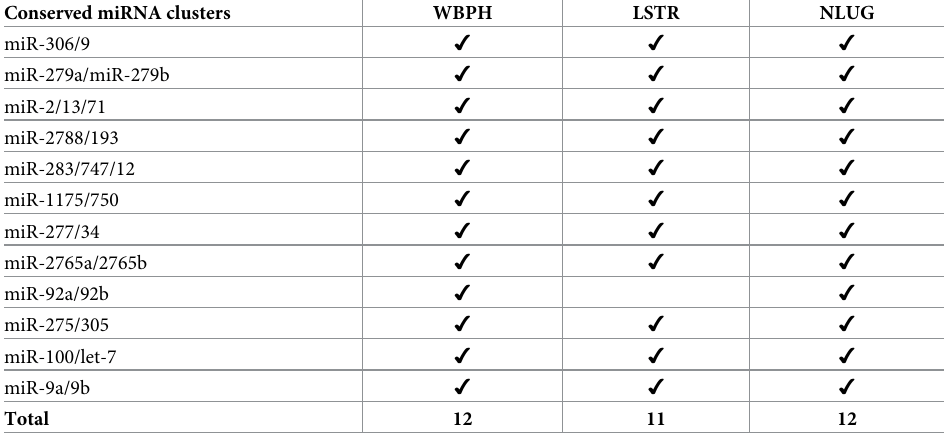
Table 1. Conserved miRNA clusters in WBPH, NLUG and